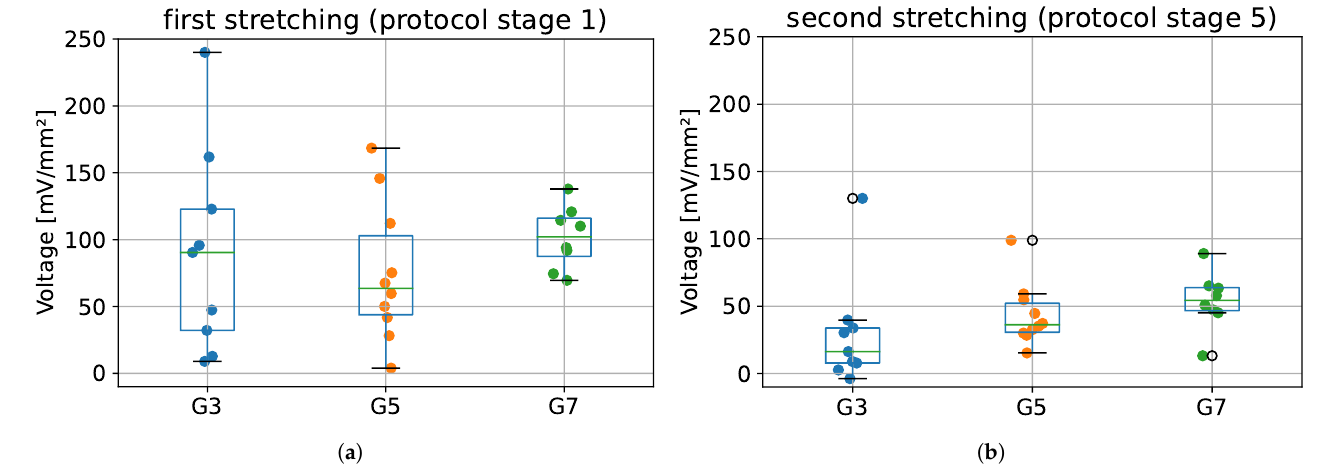
Figure 8. The maximum voltage values registered during: ( a ) the first stretching, and ( b ) second stretching. G3 group refers to porcine CDET samples, G5 refers to bovine SDFT samples, and G7 refers to deer SDFT